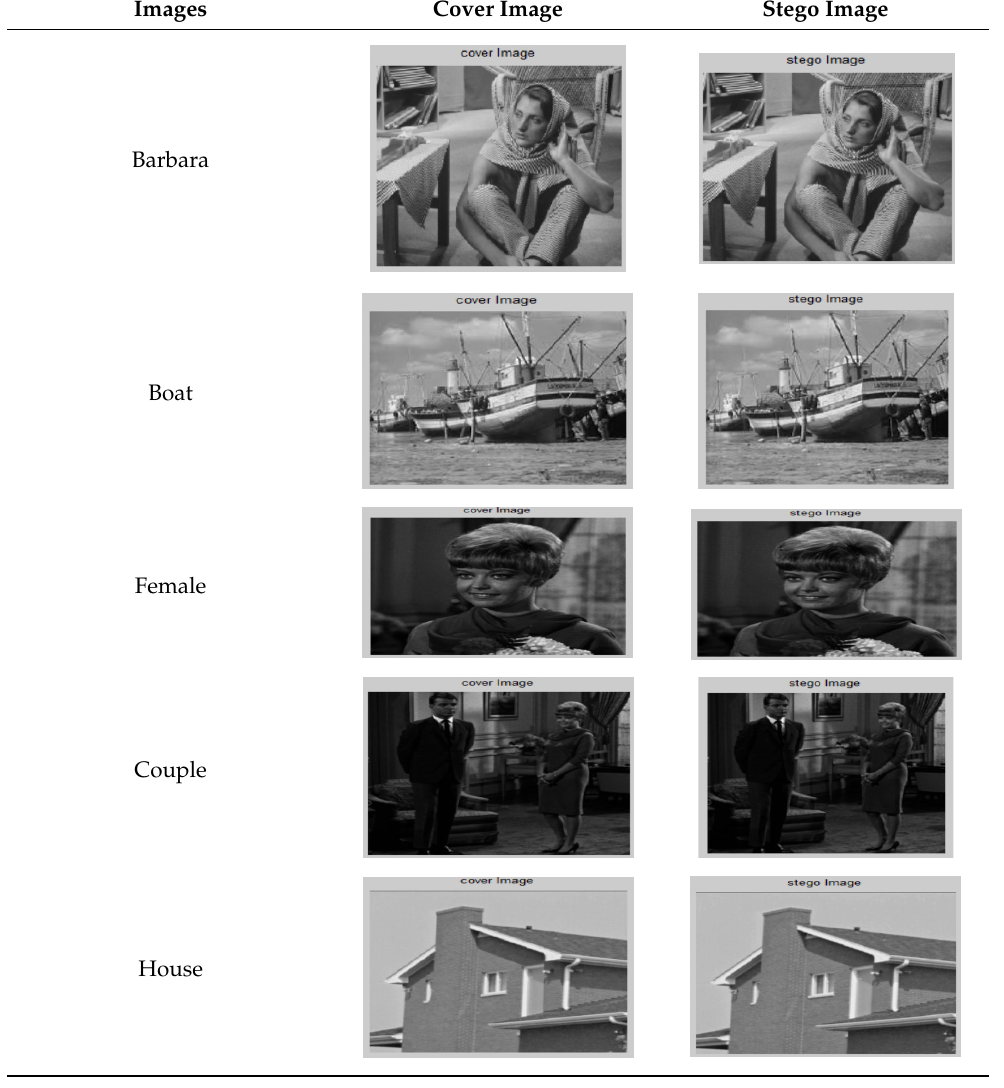
Table 3. Capacity for the standard dataset images.